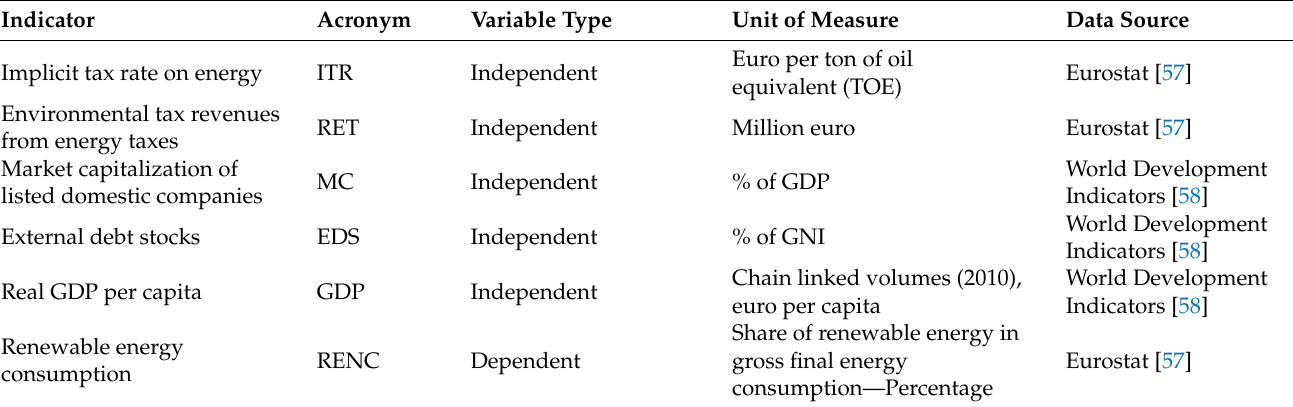
Table 1. Selected variables for the